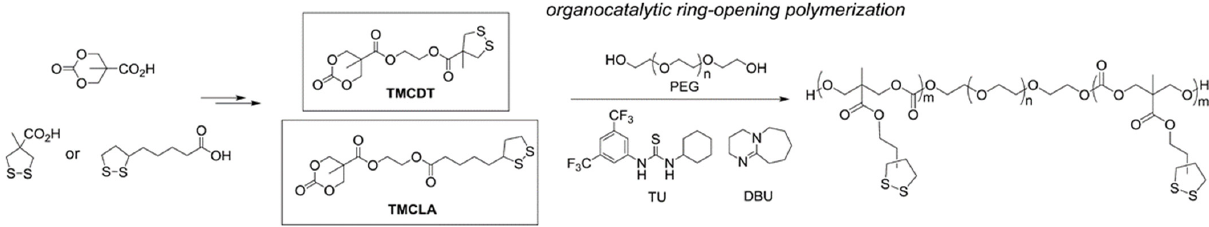
Figure 28. Synthesis of TMCDT and TMCLA, and the ring opening polymerization to form PEG-PC ABA triblock copolymers with 1,2-dithiolane pendant groups. The block copolymer product on the right is for the ring opening polymerization of TMCDT with PEG. Reprinted with permission from [31]. Copyright (2017) American Chemical Society.